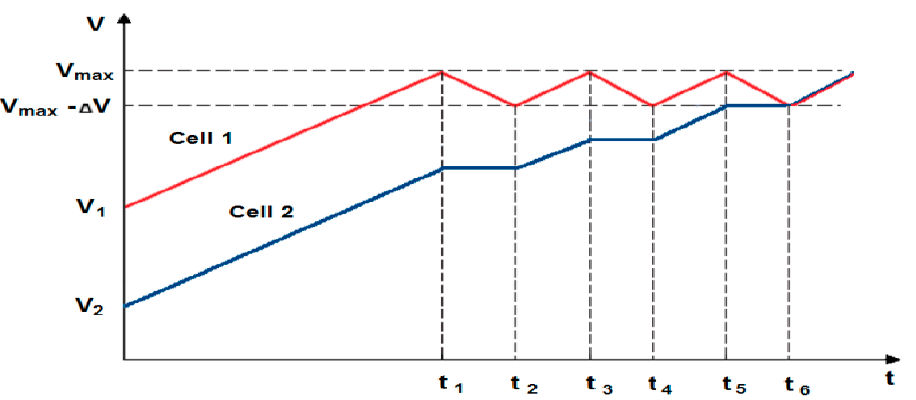
Figure 11. An example of the characteristics of passive balancing (cell 1—overcharged, cell 2—undercharged; t 1 –t 2 , t 3 –t 4 , t 5 –t 6 —duration of following discharge/charge).